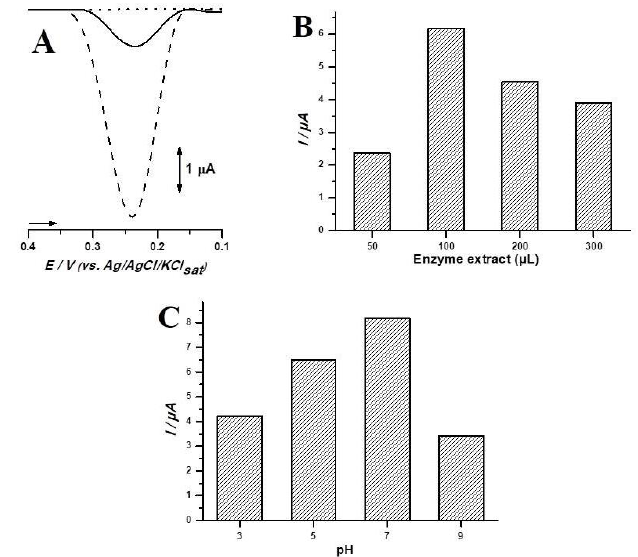
Figure 2. ( A ) Differential pulse voltamograms obtained with CP ( ▬ ) and CP-Jen100 ( ). Blank (•••). CP-Jen100 in PBS 0.1 M (pH 7.0). ( B ) Current peaks achieved through different crude vegetal extract proportions in the biosensor. ( C ) CP-Jen100 in PBS at different pH values. Analysis performed for a catechol solution of 0.07 mM in PBS 0.05 M (pH 6.0).